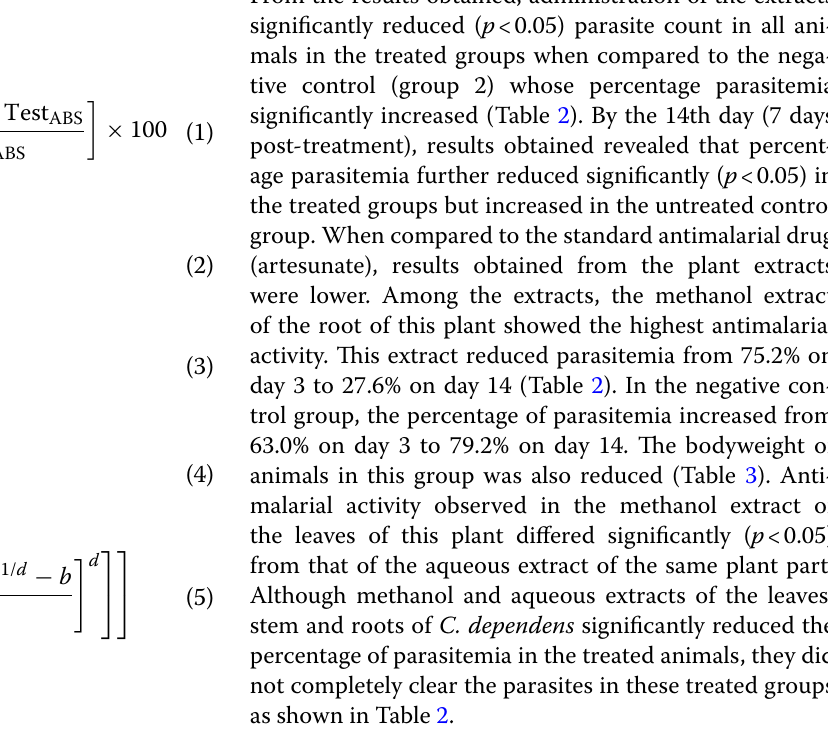
Table 1 Qualitative phytochemical analysis of crude aqueous and methanol extracts of the leaves, roots and stems of Chasmanthera dependens Phytochemical